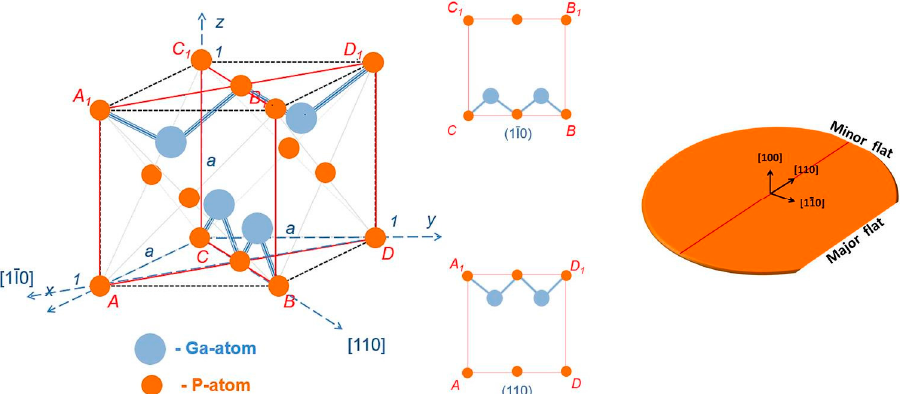
Figure 21. Zinc-blended structure of GaP with crystallographic orientations that provide opposite crystal polarities. The crystallographic planes of interest are outlined and shown separately. The right image shows a (100) GaP wafer with the standard directions of the major and minor flats.